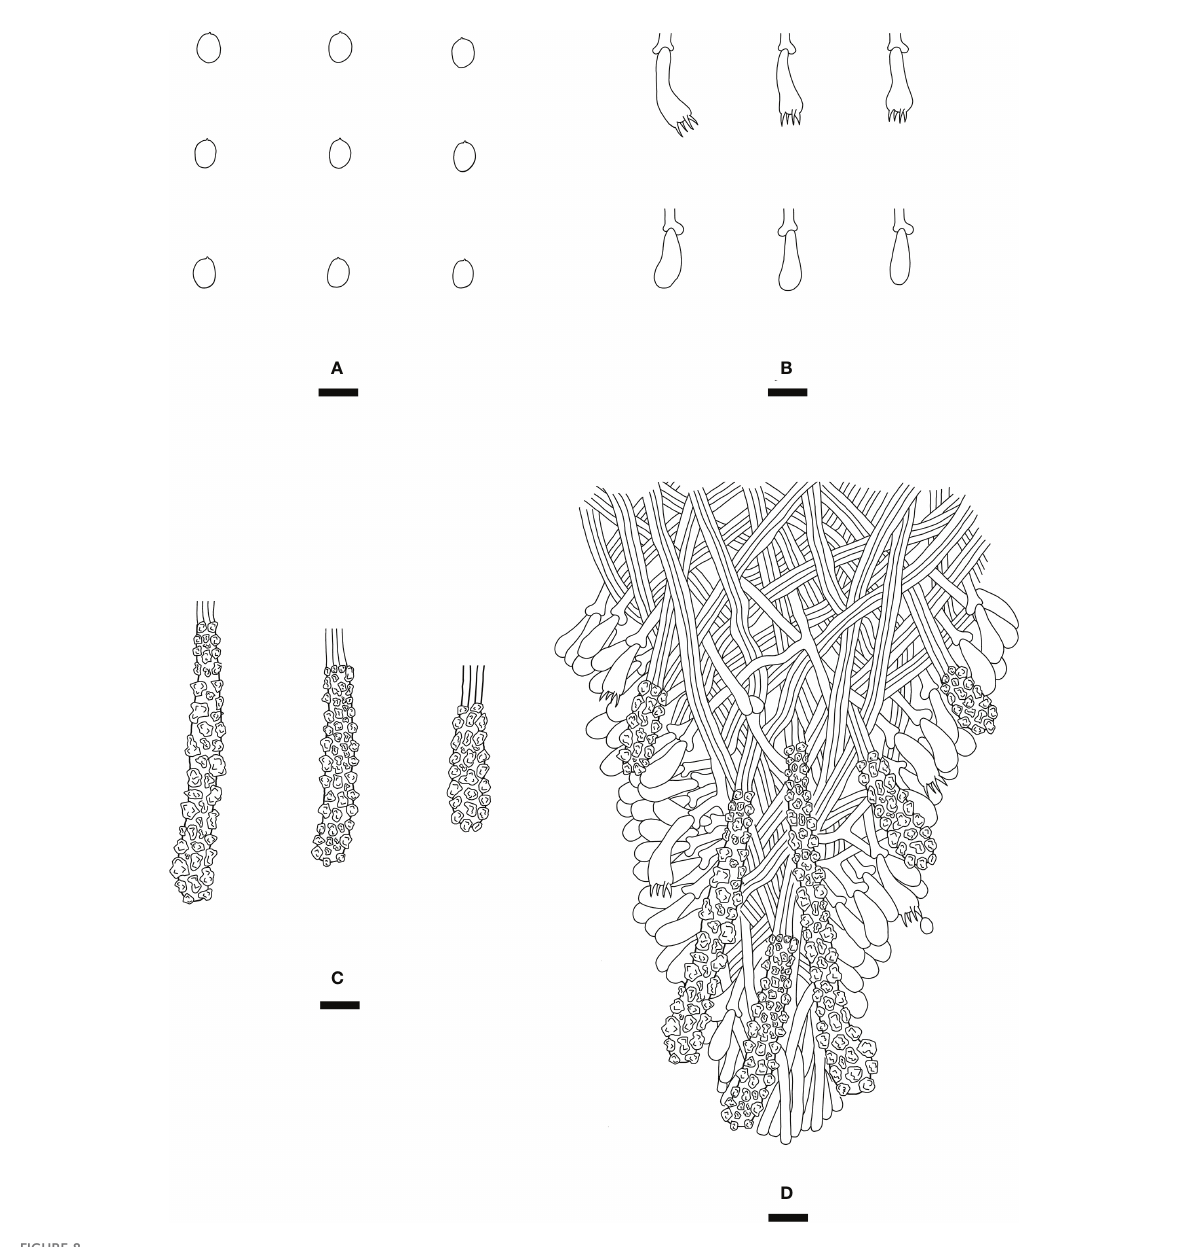
FIGURE 8 Microscopic structures of Steccherinum subtropicum (drawn from the holotype). (A) Basidiospores. (B) Skeletocystidia. (C) Basidia and basidioles. (D) A section of hymenium. Bars: (A) 5 µm; ( – D) 10